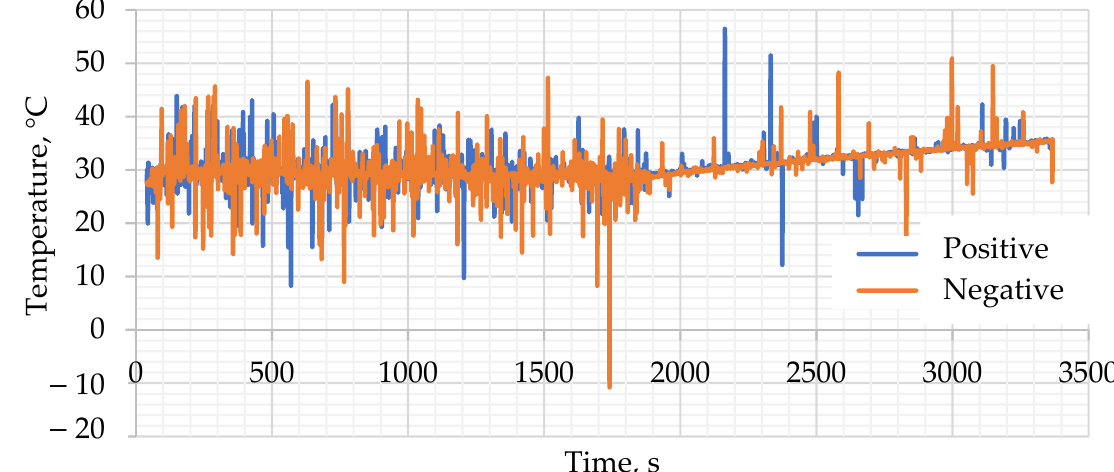
Figure 5. Positive and negative electrolyte temperature curves. The anion exchange membrane FAP450 showed a similar order of magnitude of perme- ability rates for all four vanadium ions, while in the case of the cation exchange membranes F930 and VB2, the permeability of V 2+ and VO 2+ ions was almost an order of magnitude lower than that of V 3+ and VO 2+ . As expected, the thicker VRFB of the two cation exchange membranes showed the lowest permeability values. The experimental data were applied in simulation studies to investigate the effect of ion crossover on thermal behavior